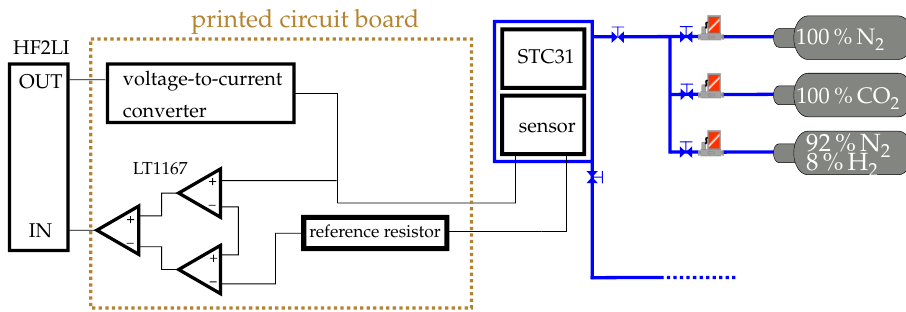
Figure 3. Schematic overview of the measurement setup: a sinusoidal voltage is provided by the lock-in amplifier (HF2LI) and transferred to a current by a voltage-to-current converter. From there the current is fed into the sensor and a reference resistor in line. The sensor is located in a gas pipeline, where a reference sensor (STC31 from Sensirion) is also present. The desired gas concentration is provided by a system of MFCs. The sensor signal is processed by instrumentation amplifiers (LT1167) and subsequently read out and digitized by the